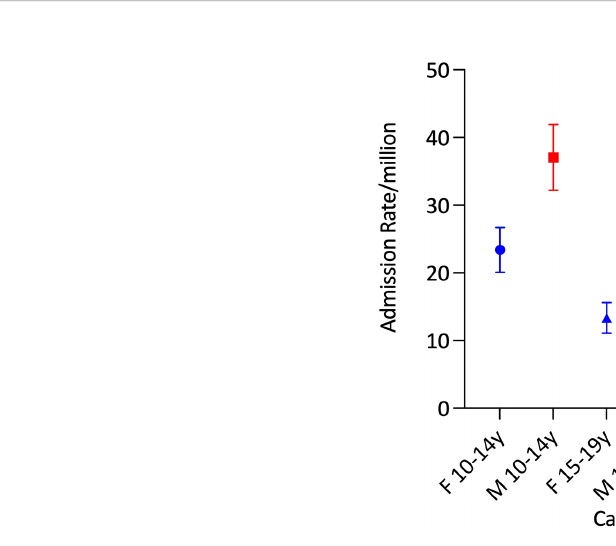
FIGURE 6 Mean secondary adrenal insuf fi ciency admission rates by age group and